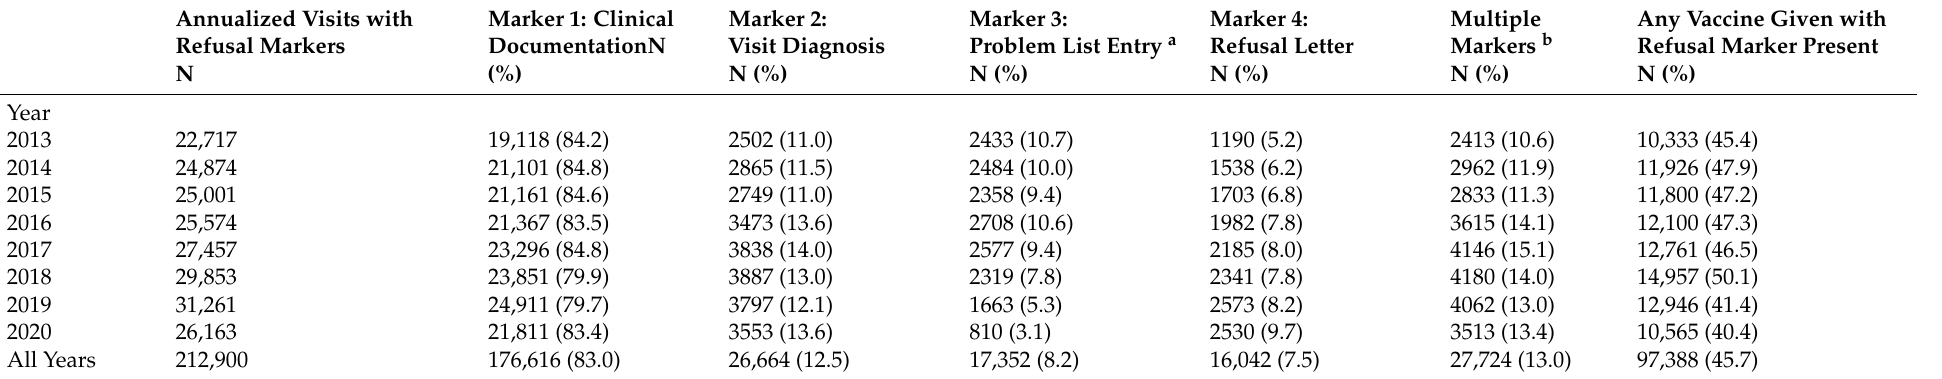
Table 4. Receipt of Any Vaccines by Patients with Refusal Markers and Distribution of Refusal Markers in the EHR by Marker Type, 2013–2020 (N =